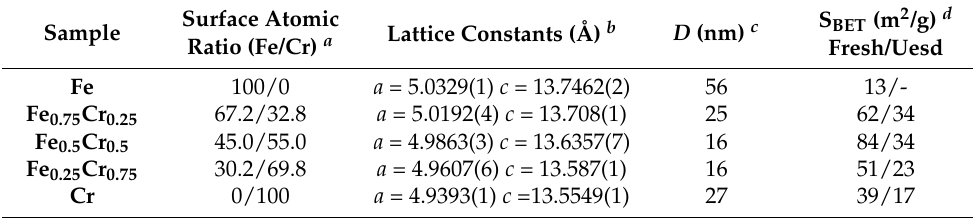
Table 1. Physical properties of fresh FeCrO x catalysts.